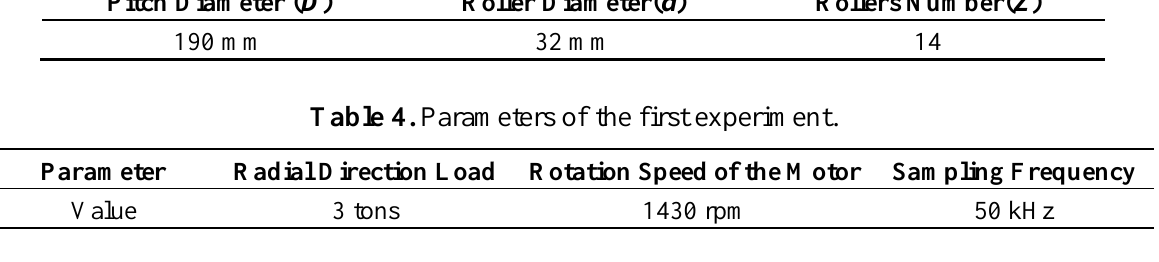
Table 5. Actual parameters of the Second constructed